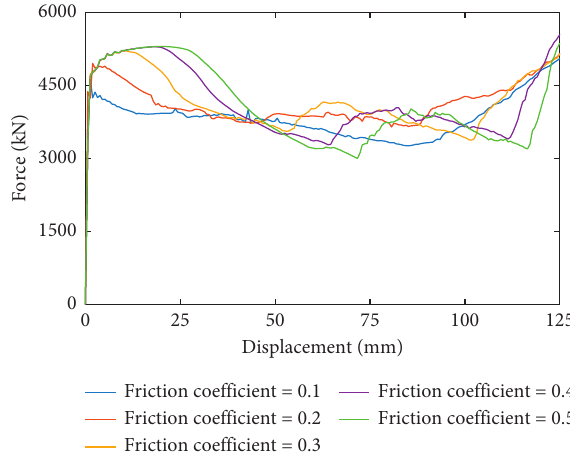
Figure 15: Load-displacement curve of the device under a different friction coefficient.